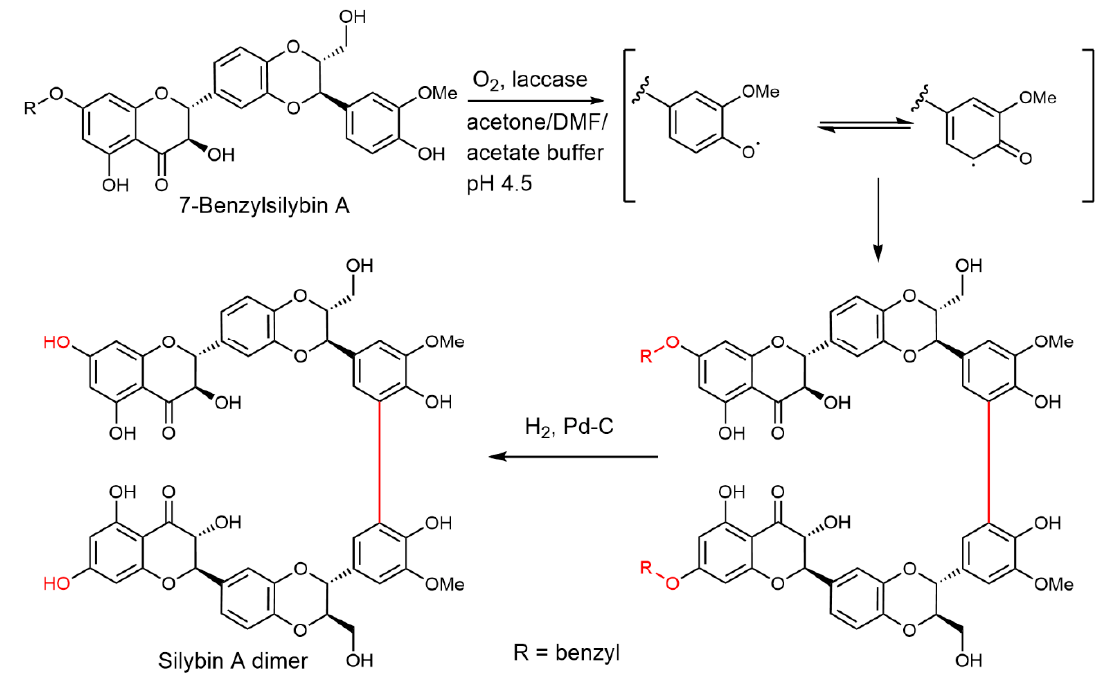
Figure 7. Laccase catalyzed dimerization of silybin A [92].